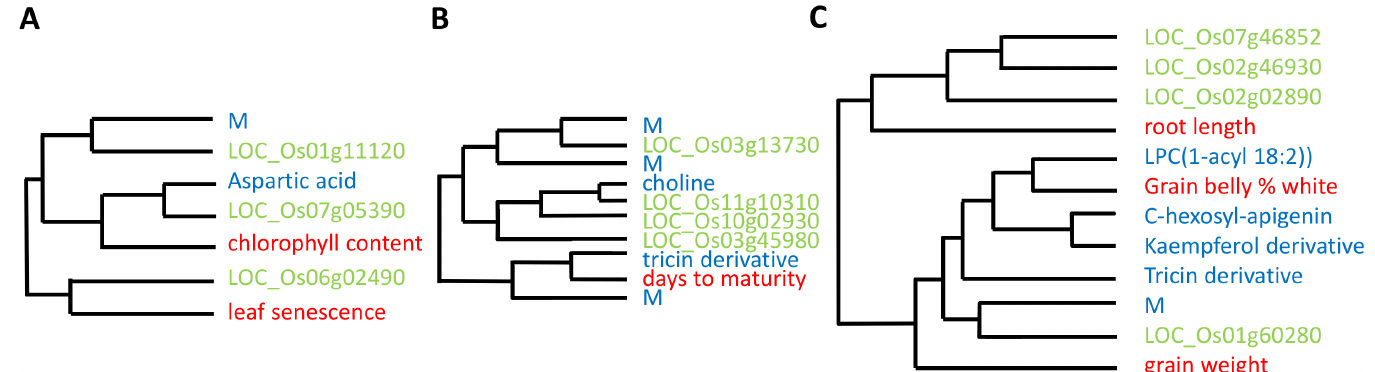
Fig 6. Parts of dendrograms based on semantic similarity between different traits. All dendrograms show semantic similarity relationships for different macroscopic traits (red), metabolitetraits (blue) and expressiontraits (green). Unidentified metabolitesare indicatedby ‘M’. (A) Semantic similarity relationships for the traits ‘leaf senescence’ and ‘chlorophyllcontent’, based on associationswith BP terms. (B) Semantic similarity relationshipsfor the trait ‘days to maturity’, basedon associationswith MF terms. (C) Semantic similarity relationshipsfor the trait ‘root length’, basedon associationswith BP terms.